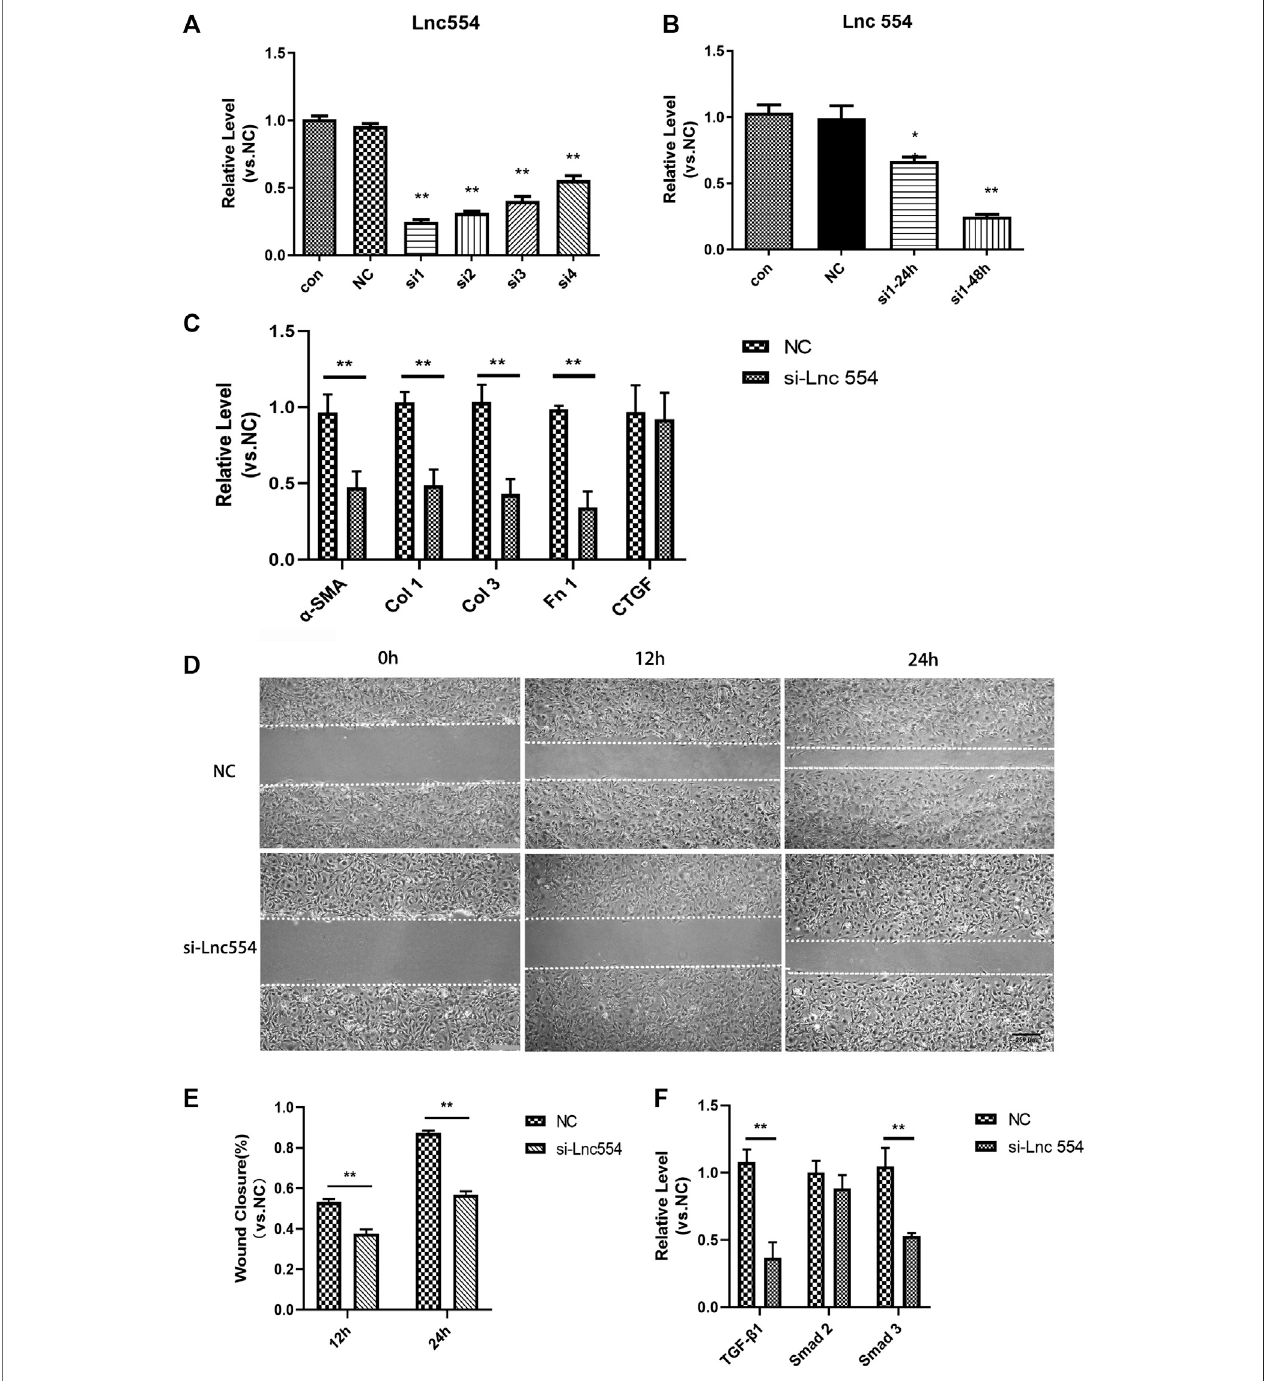
FIGURE2| KnockdownoflncRNA554attenuatesthefunctionofcardiac fi broblastsandreducestheexpressionofTGF- β 1anditsdownstream (A) qRT-PCRwas used to detect the expression of lncRNA 554 in CFs after siRNA transfection. Control, untreated group; NC, scrambled control siRNA transfection group; Si1-4, siRNA transfectiongroup.** p < 0.01vsNC,n (cid:2) 5; (B) TheCFswastransfected withsi1withdifferenttime(24 h,48 h),andthenqRT-PCRwasconductedtodetectthelevelof lncRNA 554. ** p < 0.01 vs NC, n (cid:2) 5; (C) After silencing of lncRNA 554, the level of ECM mRNAs ( α -SMA, Col 1, Col 3, Fn 1, CTGF) were analyzed by qRT-PCR. ** p < 0.01vsNC,n (cid:2) 5; (D) and (E) Theef fi ciencyofhealinginlncRNA554silencinggroupandNCgroupwasanalyzedbywoundinghealingassayatdifferenttime(0,12 and 24 h). ** p < 0.01 vs NC, n (cid:2) 5. Scale bars, 250 μ m; (F) After silencing of lncRNA 554, qRT-PCR was conducted to detect the level of TGF- β 1 pathway (TGF- β 1, Smad 2, Smad 3). ** p < 0.01 vs NC, n (cid:2) 5.